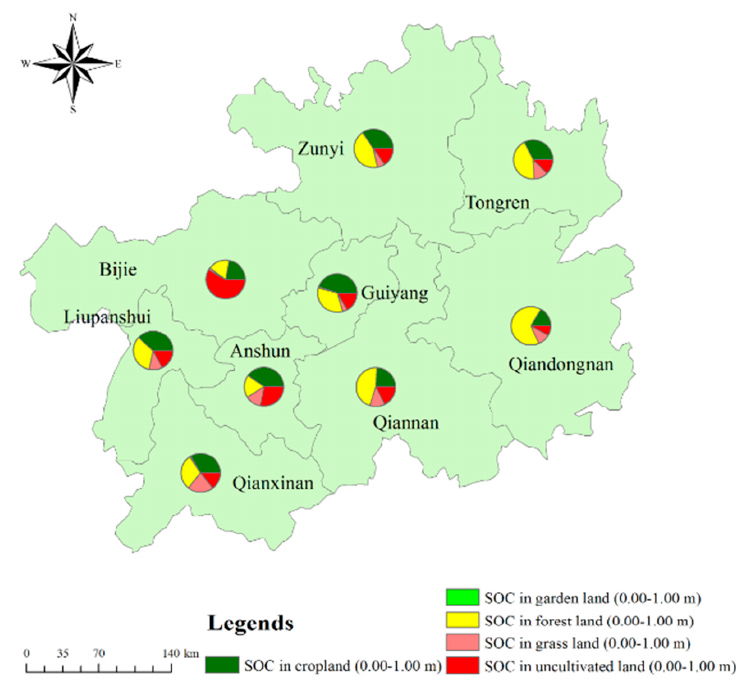
Figure 4. Proportions of SOC from different land uses in different districts in Guizhou Province.